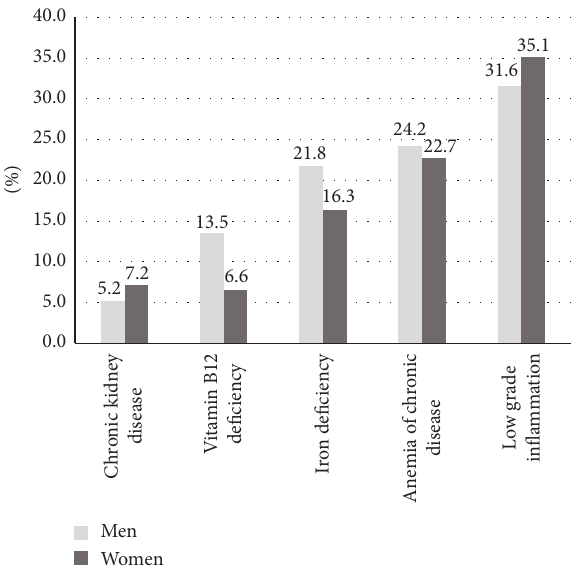
Figure 2: Selected causes of anemia among older adults in Ecuador, SABE